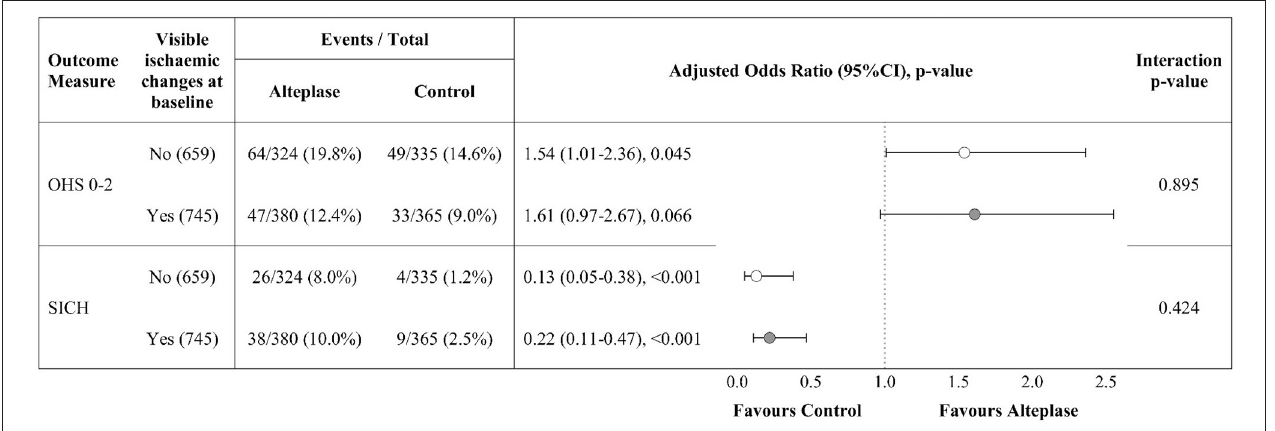
Frontiers in Radiology |